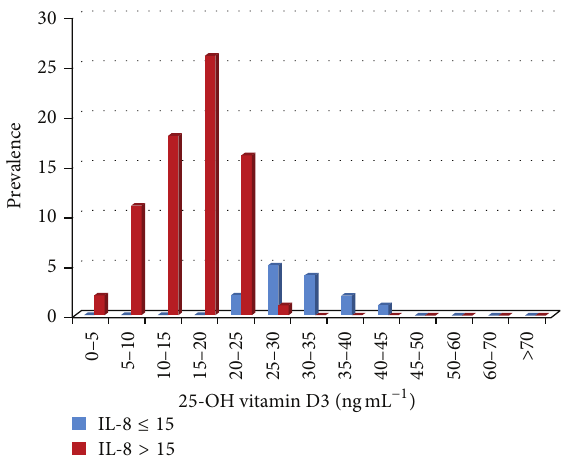
Figure 5: 25-OH vitamin D3 (ng mL −1 ) serum level in melanoma patients for individuals with normal and high serum IL-8 (pgmL −1 ). Prevalence depicts the subgroups of melanoma patients with high serum IL-8 congregating in the low serum 25-OH vitamin D3